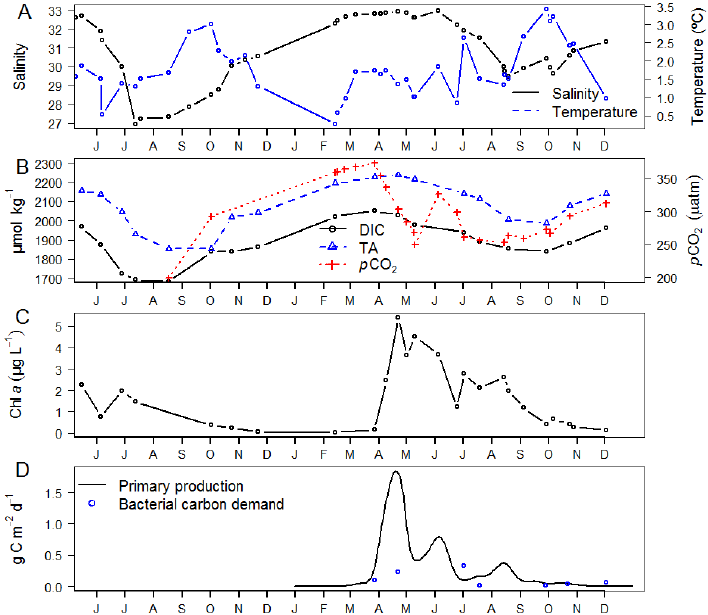
Figure 7. Time series of (a) average (0–40m) salinity and temperature ( ◦ C) ; (b) DIC, TA (µmolkg − 1 ) and CO 2 partial pressure ( p CO 2 , µatm); (c) chlorophyll a concentration (µgL − 1 ); (d) and primary production and bacterial carbon demand (gCm − 2 d − 1 ) from June 2012 to December 2013 for station GF10.